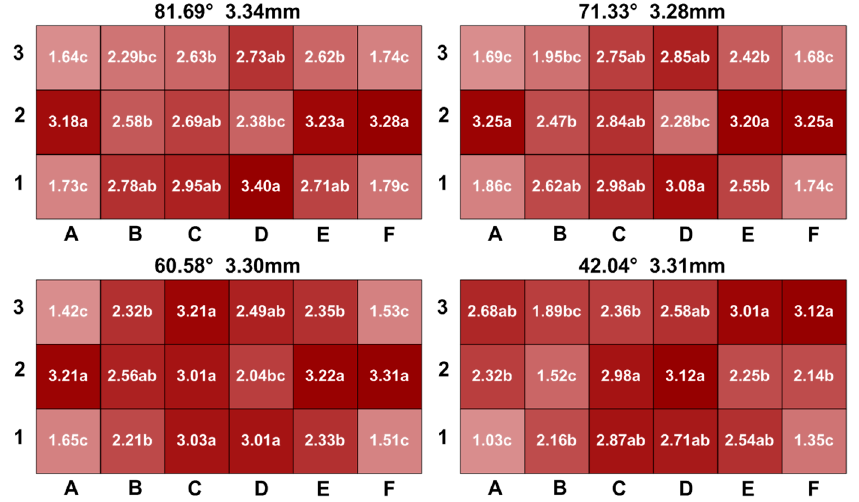
Figure 7. Spatial distribution of drop diameter (D 50 ) of throughfall. Different letters indicate significant difference between data in each treatment ( p < 0.05). The data, directly above each subplot, represent the mean value of the landing angle and D 50 of sprinkler irrigation droplets when there was no maize crown.